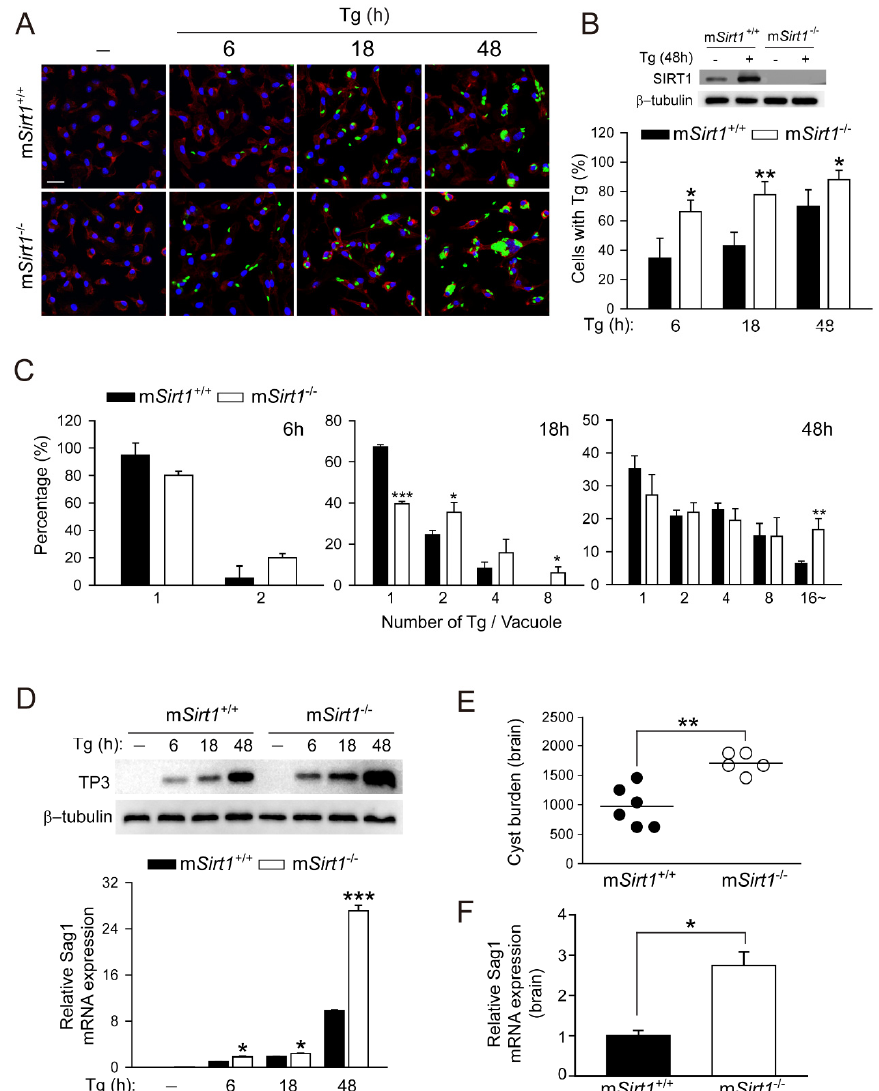
Figure 1. Myeloid SIRT1 is essential for host protection against T. gondii infection in primary macrophages and mice. ( A – C ) BMDMs from m Sirt1 +/+ and m Sirt1 − / − mice were infected with GFP-conjugated T. gondii RH strain (MOI = 1) for the indicated periods. Cells were fixed and stained with Texas Red ® -X phalloidin for F-actin in the cytoskeleton (red) and DAPI for nuclei (blue), respec- tively. ( A ) Fluorescent images showing the number of intracellular T. gondii . ( B , C ) Number of T. gondii RH-infected cells (for B ) and T. gondii RH per vacuole (for C ) were quantified. Scale bar = 25 µ m ( D ) BMDMs from m Sirt1 +/+ and m Sirt1 − / − mice were infected with T. gondii RH strain (MOI = 1) for the indicated time periods. TP3 protein expression (top) and Sag1 mRNA expression (bottom) was examined by immunoblot and qPCR analysis, respectively. ( E , F ) m Sirt1 +/+ and m Sirt1 − / − mice (n = 5 per group) were infected with 40 cysts of the ME49 strain (i.p. injection) for 3 weeks. ( E ) The number of cysts in the brain was counted under a microscope. ( F ) Sag1 mRNA expression in brain homogenates was evaluated by real-time qPCR analysis. Data are representative of three independent experiments and are presented as means ± SD (for B – D ) or ± SEM (for F ). * p < 0.05, ** p < 0.01, *** p < 0.001, compared with control cultures or control mice infected with T. gondii (two-tailed Student’s t -test). Tg, Toxoplasma gondii